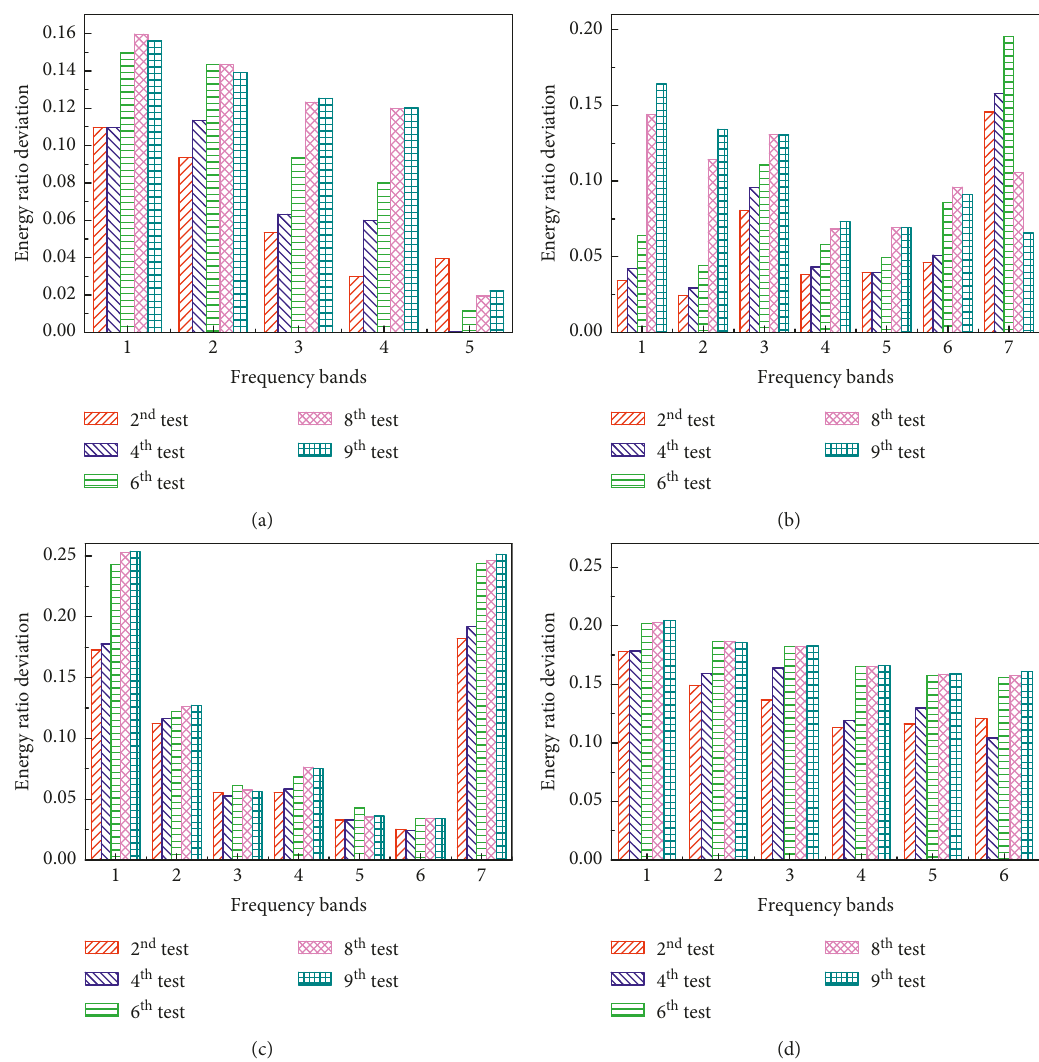
Figure 23: Hilbert damage feature vector spectrum in field tests. (a) Point 1. (b) Point 2. (c) Point 5. (d) Point 7.